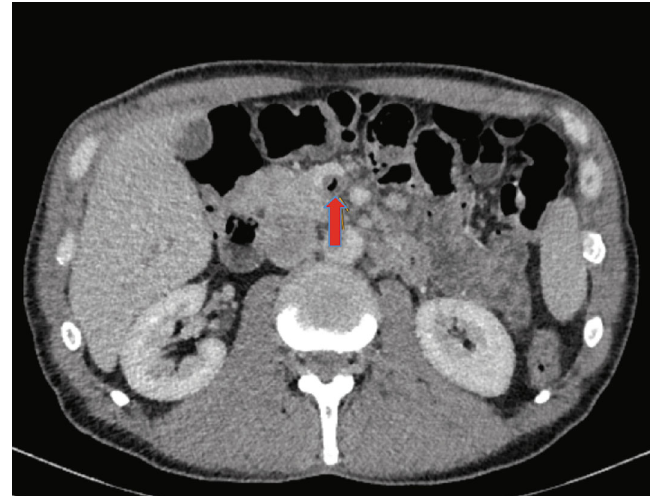
Figure 2: Pneumatosis of the superior mesenteric